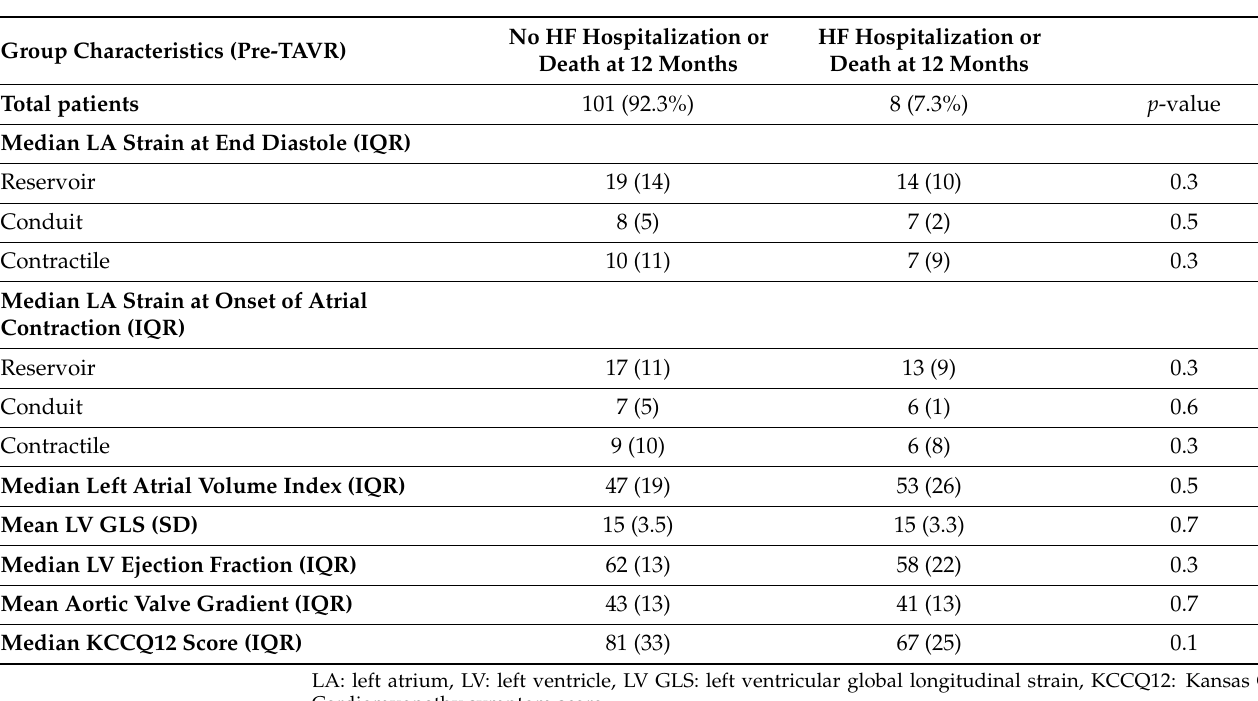
Table 5. Baseline echocardiographic and clinical parameters according to heart failure hospitalization or death at 12 months.